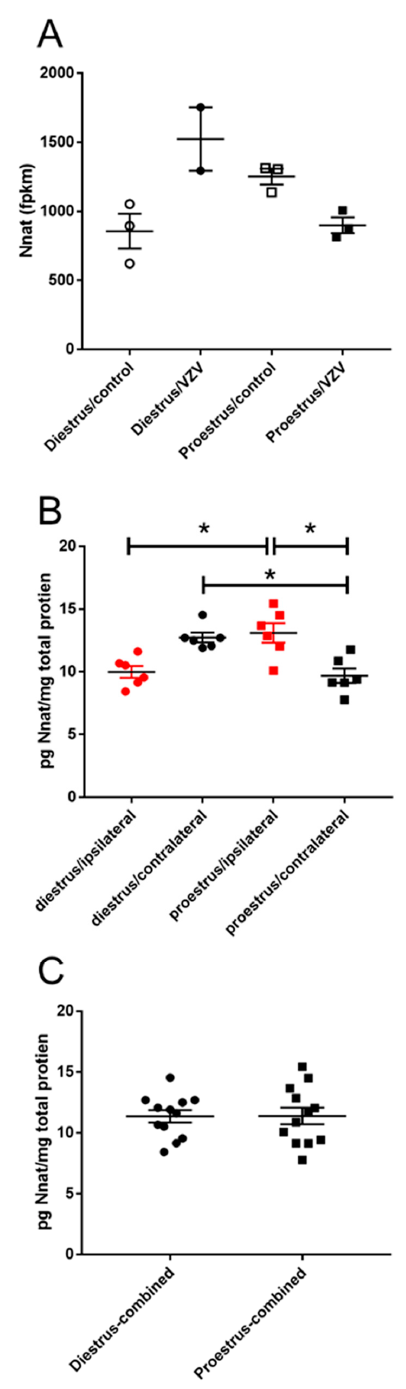
Figure 3. Expression of neuronatin (Nnat) significantly increased in the parabrachial region during diestrus. Rats were injected with varicella zoster virus in the left whisker pad to induce orofacial pain. Parabrachial brain tissue was collected from these female rats during the proestrus and diestrus phase of the estrous cycle. This tissue was analyzed for RNA (panel A ) and protein (panels B , C ). In panel ( B ) the right (contralateral to VZV injection) and left (ipsilateral to VZV injection) side of the brain was analyzed separately and in panel ( C ) the protein content from both sides of the brain were combined. Fragments Per Kilobase of transcript per Million mapped reads (fpkm). The asterisk indicates a significant di ff erence between groups p <